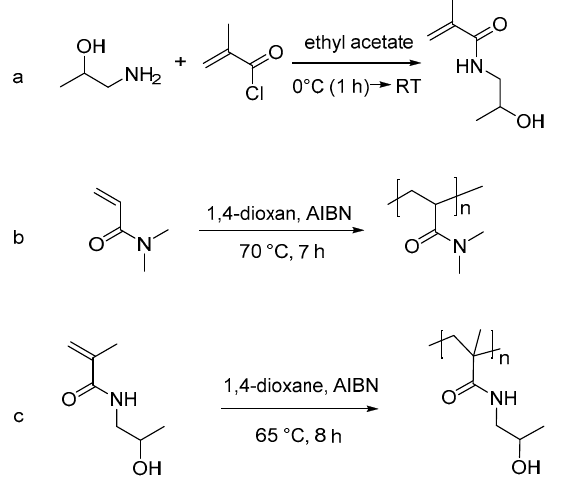
Figure 1. Synthesis of ( a ) monomer N -(2-hydroxypropyl) methacrylamide (HPMA) and homopolymers ( b ) PDMAAm and ( c ) PHPMA.